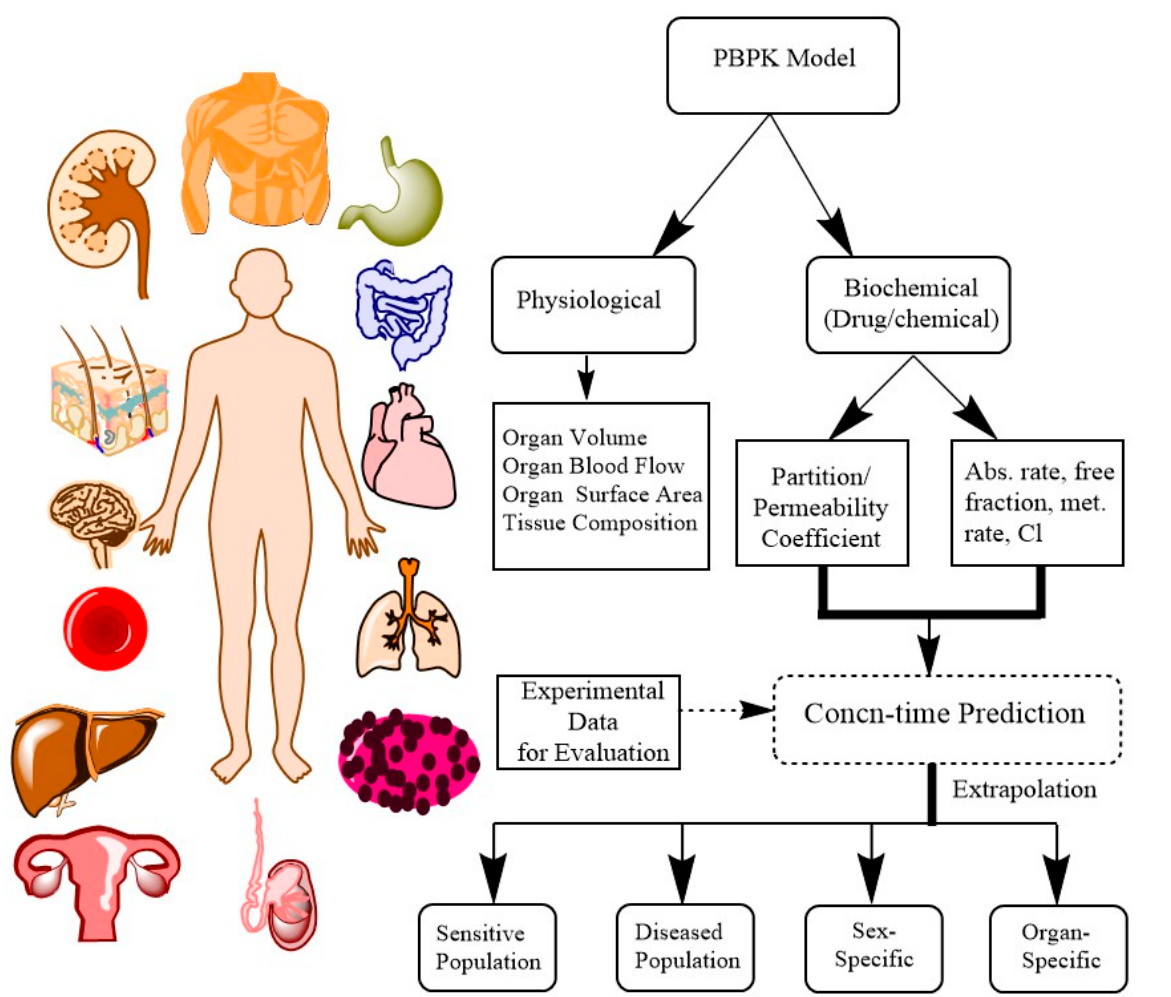
Figure 1. Conceptual diagram for PBPK model representing physiological and biochemical parameters and extrapolation of the model for human health risk assessment.